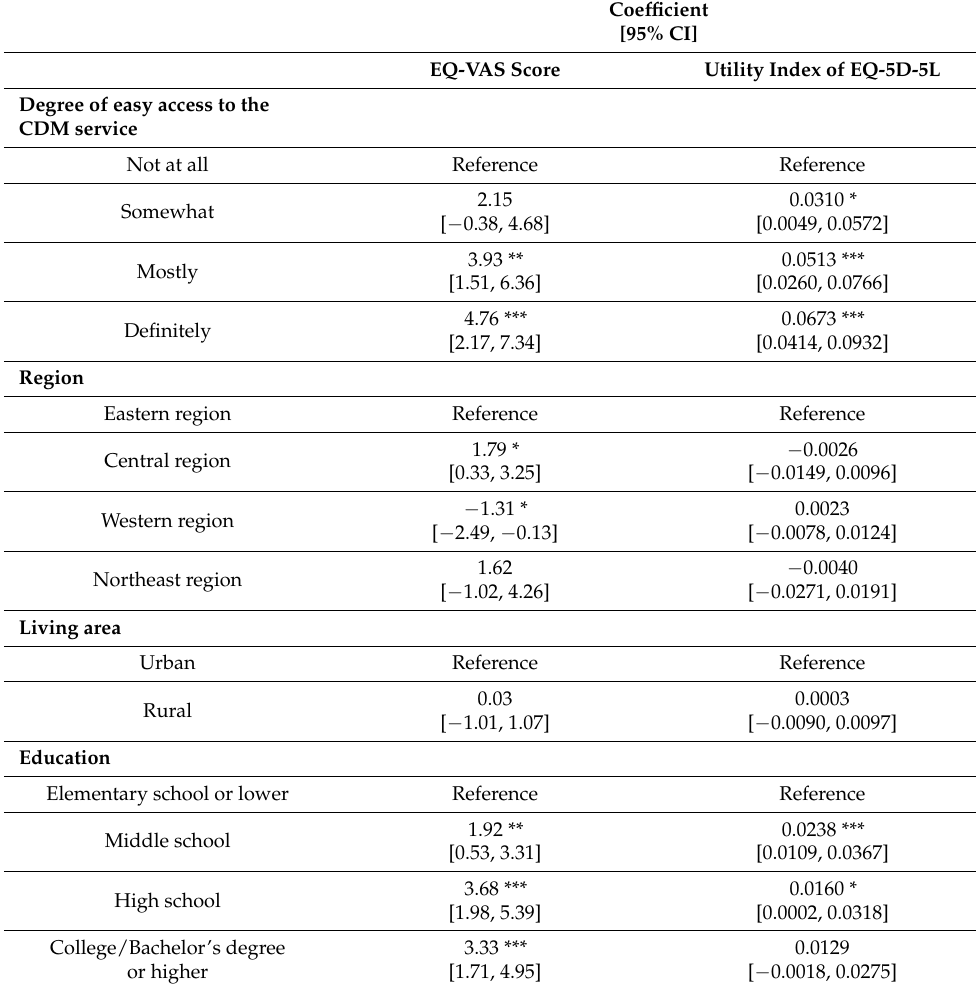
Table 3. Multivariate linear regression: by EQ-VAS score and utility index of